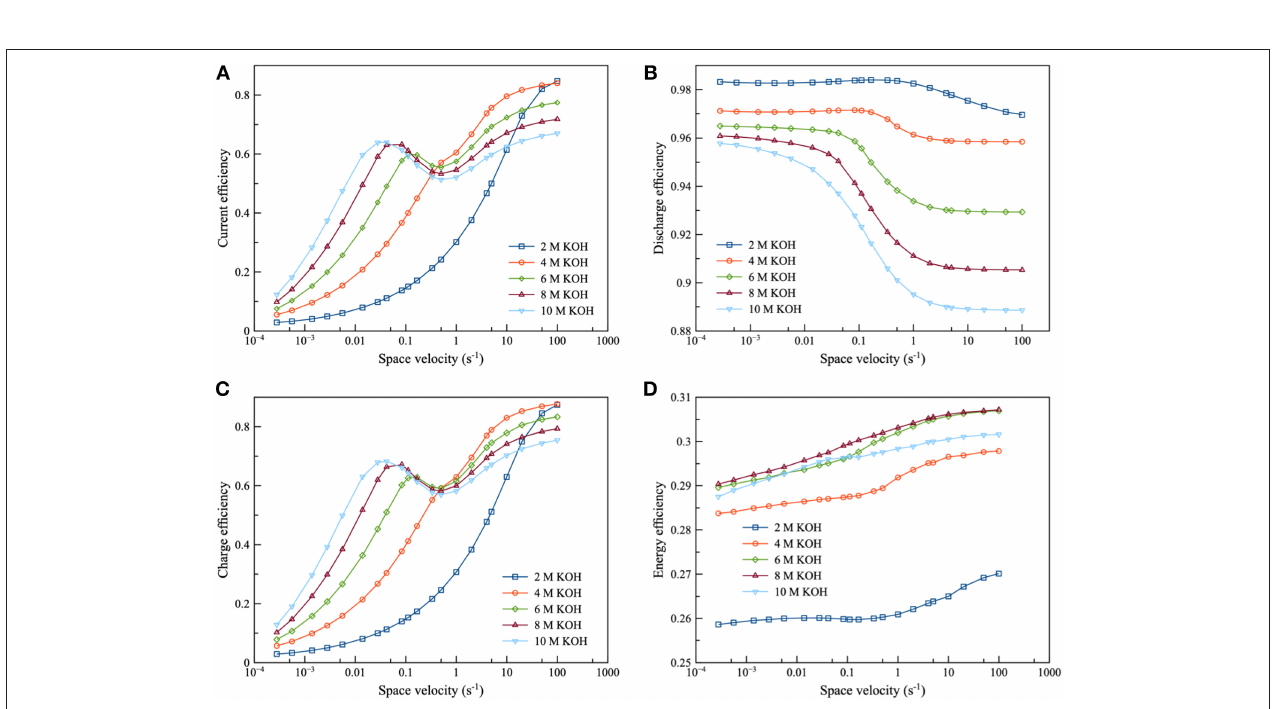
FIGURE 10 | Effects of KOH concentration using 0.2M zincate ion initial concentration at charge and discharge current density of 100 mA/cm 2 : (A) current efficiency as a function of space velocity (B) discharge efficiency as a function of space velocity (C) charge efficiency as a function of space velocity and (D) energy efficiency as a function of space